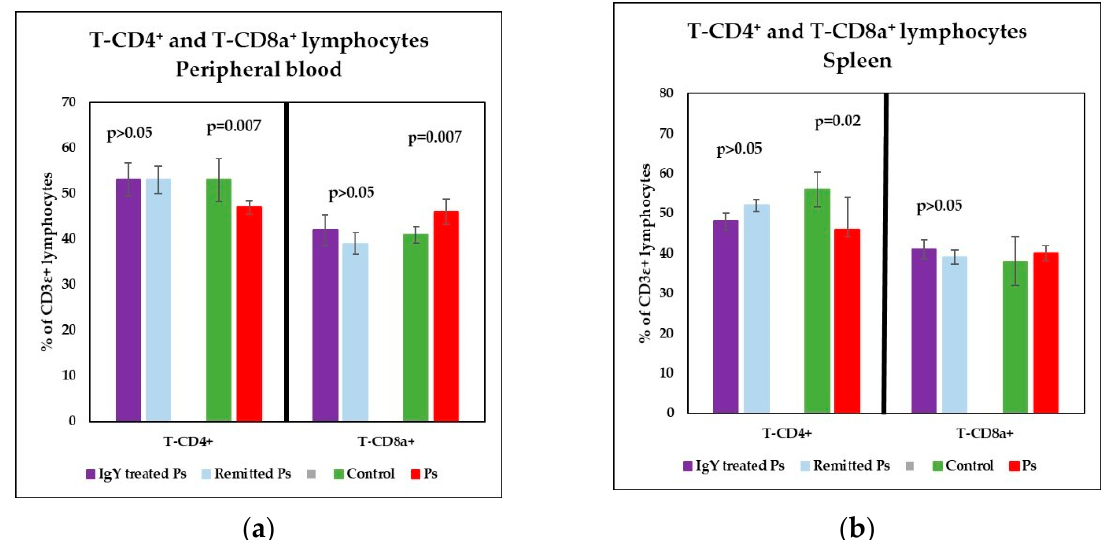
Figure 4. Distribution of T-CD4 + and T-CD8a + lymphocytes in peripheral blood and spleen cell suspension. ( a ) Peripheral blood-distribution of T-CD4 + and T-CD8a + lymphocytes for IgY-treated Ps group ( n = 12) (53 ± 3.6 and 42 ± 3.3) as compared to naturally remitted Ps group ( n = 8) (53 ± 3 and 39 ± 2.4), control group ( n = 8) (53 ± 4.7 and 41 ± 1.8) and Ps group ( n = 8) (47 ± 1.5 and 46 ± 2.8); ( b ) Spleen cell suspension-distribution of T-CD4 + and T-CD8a + lymphocytes for IgY-treated Ps group ( n = 12) (48 ± 2.2 and 41 ± 2.3) as compared to naturally remitted Ps group ( n = 8) (52 ± 1.5 and 39 ± 1.8), control group ( n = 8) (56 ± 4.3 and 38 ± 6.1) and Ps group ( n = 8) (46 ± 8.1 and 40 ± 1.9). The results (% of CD3 ε + lymphocytes) are presented as mean ± SD; n = number of mice).